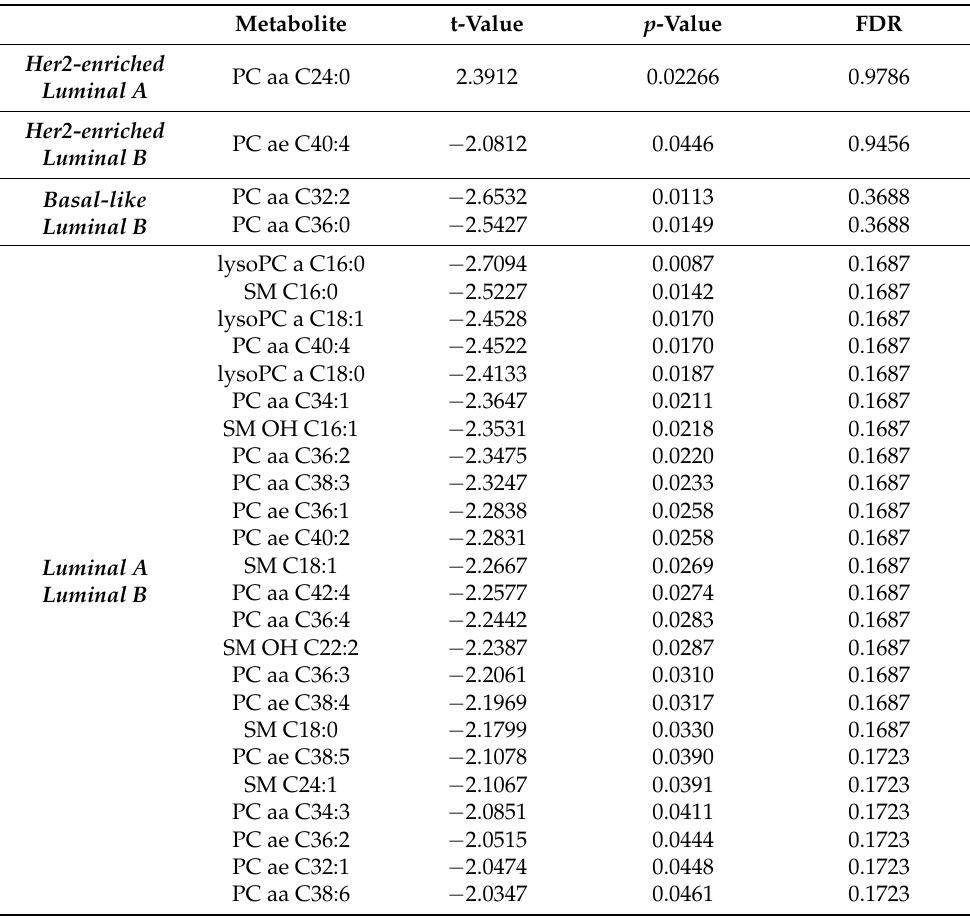
Table A2. Analysis of molecular subtypes tested against each other.